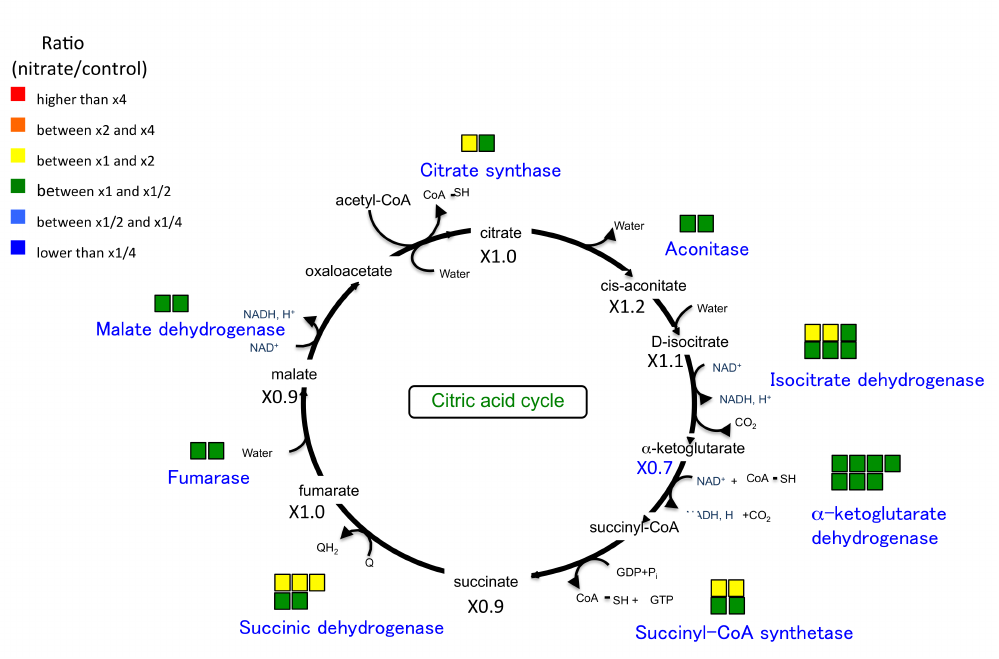
Figure 6. Ratios of gene expression and metabolite concentrations related to tricarboxylic acid (TCA) cycle in soybean roots and nodules after 24 h of the 5-mM nitrate treatment. ( A ) Ratios of gene expression and metabolite concentrations in the roots. ( B ) Ratios of gene expression and metabolite concentration in the nodules. The model shows the metabolic map of glycolysis in the root or nodule cells. The color of squares above enzyme name and the number under the compound abbreviation indicate the same as Figure